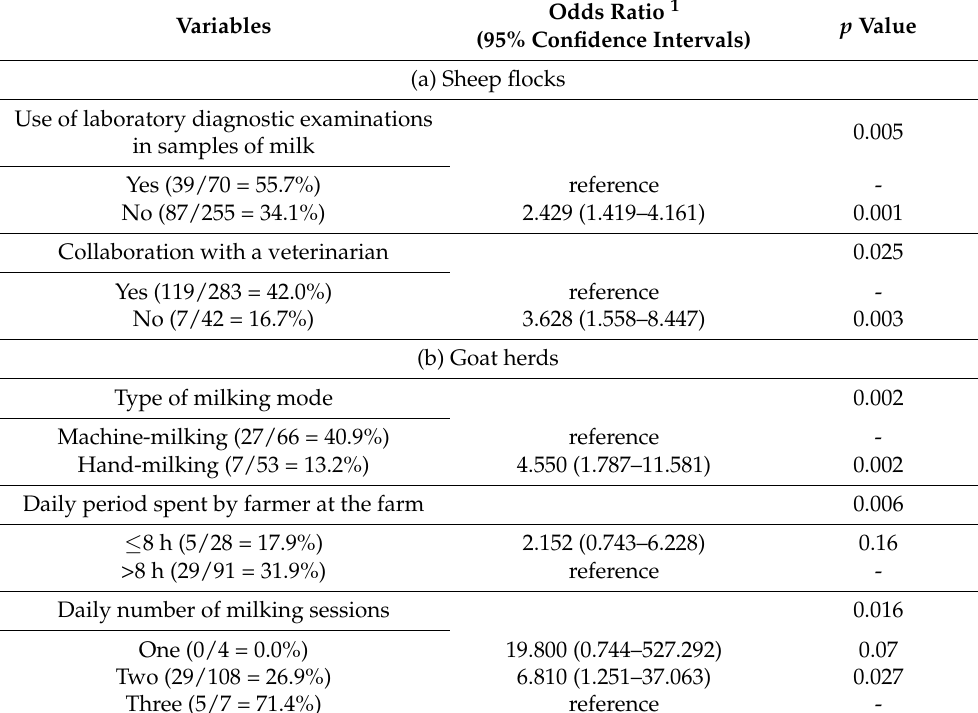
Table A8. Multivariable analysis for variables associated with optional vaccination against staphylo- coccal mastitis in 444 small ruminant farms in